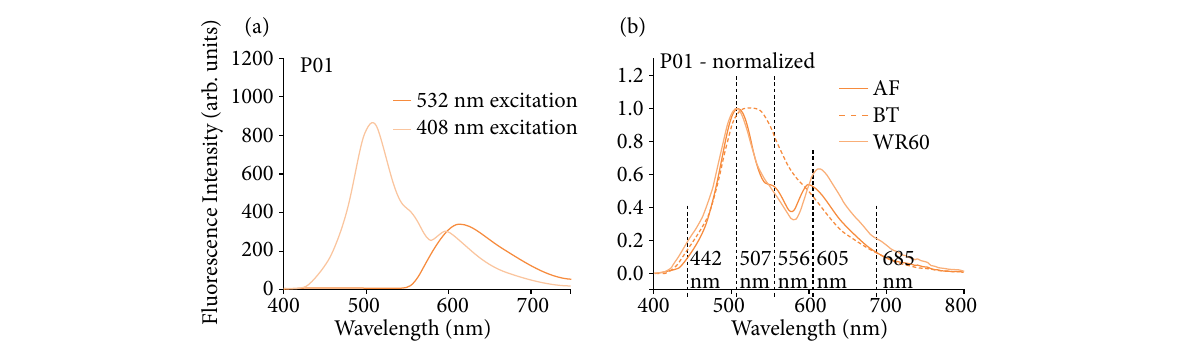
Figure 1 - Comparison between fluorescence spectra at 532 and 408 nm excitation, with examples of spectra obtained for patient P01. (a) Note the only the band centered around 600 nm is observed for both spectra, whereas 408 nm excitation provides other spectral regions to be analyzed; normalized spectra, indicating the peak absorption wavelengths observed for different stages: endogenous fluorescence (AF) and back-table (BT) stages prior to organ graft implantation, and 60 min after anastomoses finalization (WR60); (b) The main decrease in fluorescence when compared to AF was about 556 nm (green spectral region with intense light absorption by blood